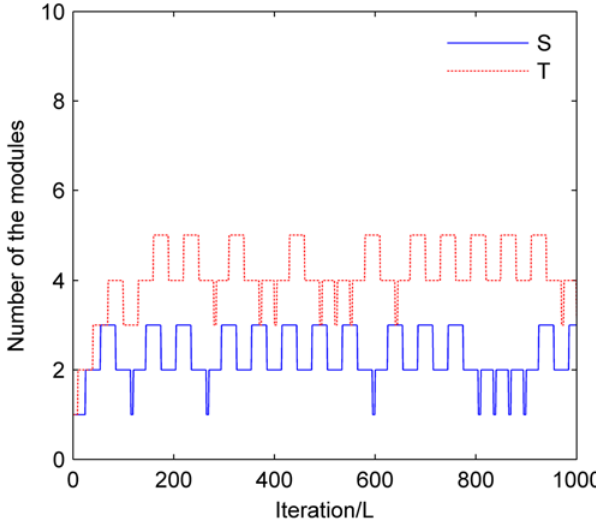
Figure 5. Distributions of the numbers of epistatic and LD modules. Model 7 with parameters MAF=0.2 and r 2 =1 is extended to include two epistatic modules and four LD modules. Results are obtained with parameters n 1 =10 and n 2 =5.